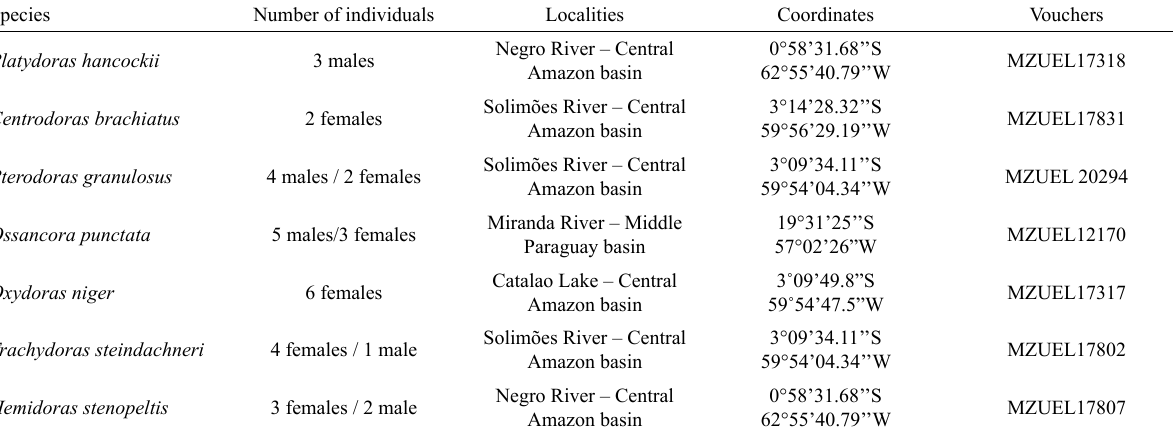
Table 2 – Information about the species under study, their sex, collection sites and Vouchers in Ichthyological Collections. Species